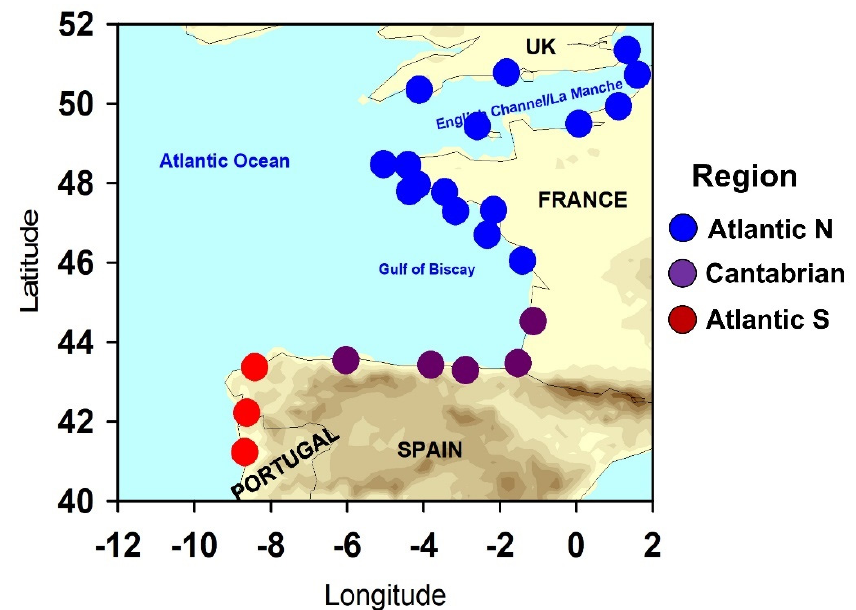
Figure 3. Regionalization of the summer (JA) daily HCI: Beach index on the study area based on the Principal Component loadings matrix.